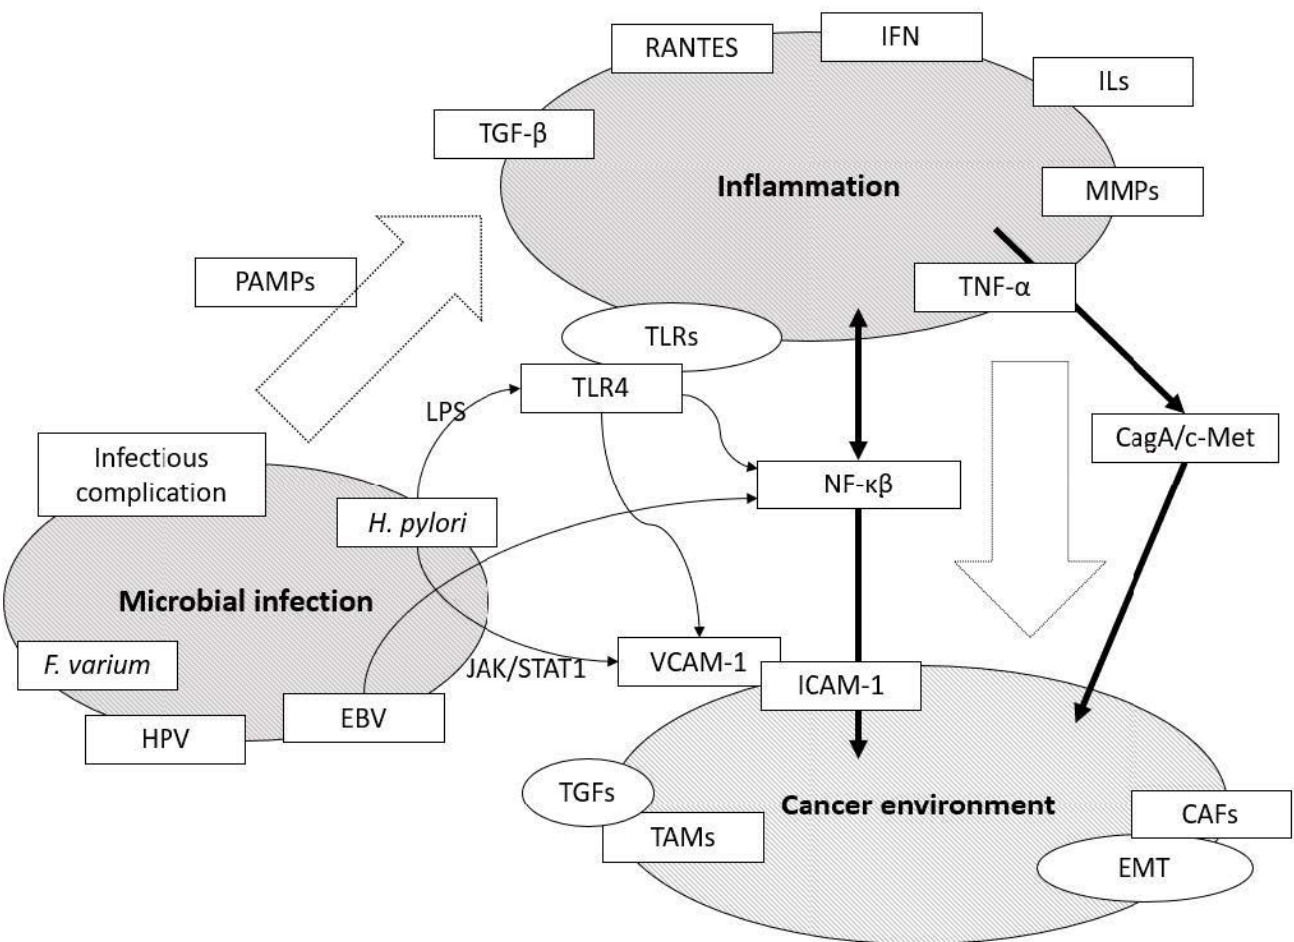
Figure 1. An overview of the links between microbial infection, chronic inflammation, and cancer environment. Several signaling pathways, such as TLR4 and CagA/c-Met, and mediators selected by microbial inflammation play an important role in the development of gastrointestinal cancers. EBV: Epstein-Barr virus; CAFs: Cancer associated fibroblasts; EMT: Epithelial mesenchymal transition; HGF: Hepatocyte growth factor; HPV: Human papilloma virus; IFN: Interferon; ILs: Interleukins; ICAM-1: Intercellular adhesion molecule-1; JAK/STAT1: Janus kinase/Signal transducer and activator of transcription 1; LPS: Lipopolysaccharide, MMPs: Matrix metalloproteinases; NF- κβ : nuclear factor-kappa β ; PAMPs: Pathogen-associated molecular pattern molecules; RANTES: Regulated on activation, normal T cell expressed and secreted; TAMs: Tumor associated macrophages; TGFs: Transforming growth factor; TLR: Toll-like receptor; TNF- α : Tumor necrosis factor- α ; VCAM-1: Vascular cell adhesion